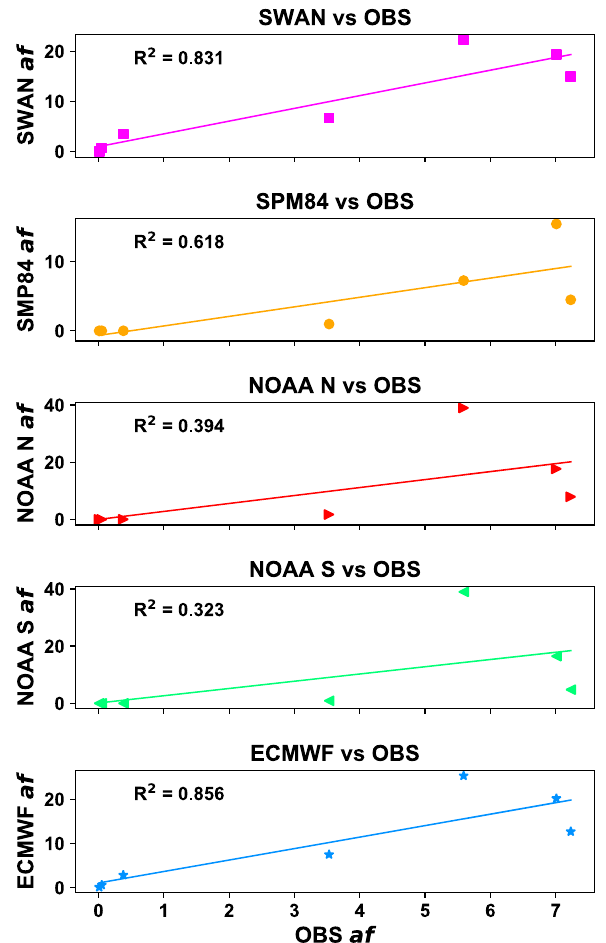
Figure 12. Scatter plots of each hindcasted model af versus the observed af . Water 2018 , 10 , x FOR PEER REVIEW